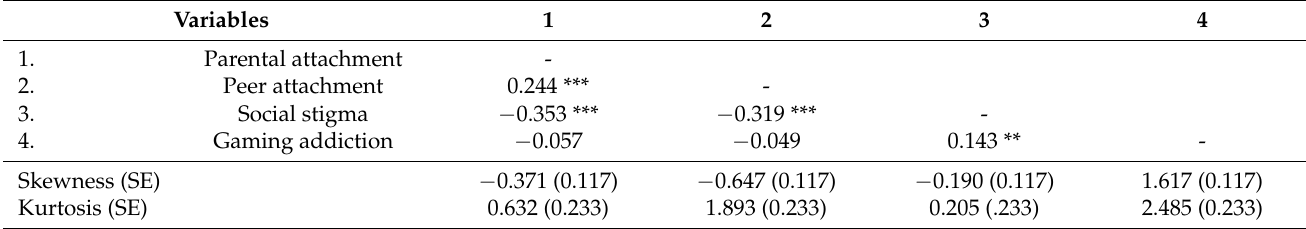
Table 2. Correlation